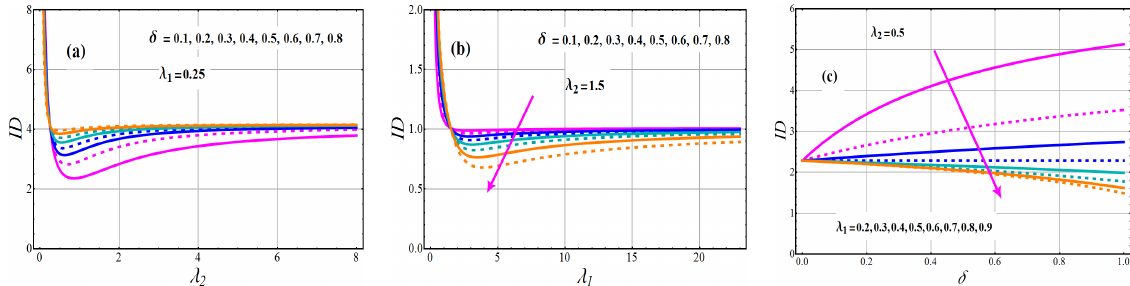
Fig. 5. Variations of Index of dispersion of TC-MAM ( $ ) . Figure 5. Variations of index of dispersion of TC-MAM ( (cid:118) )